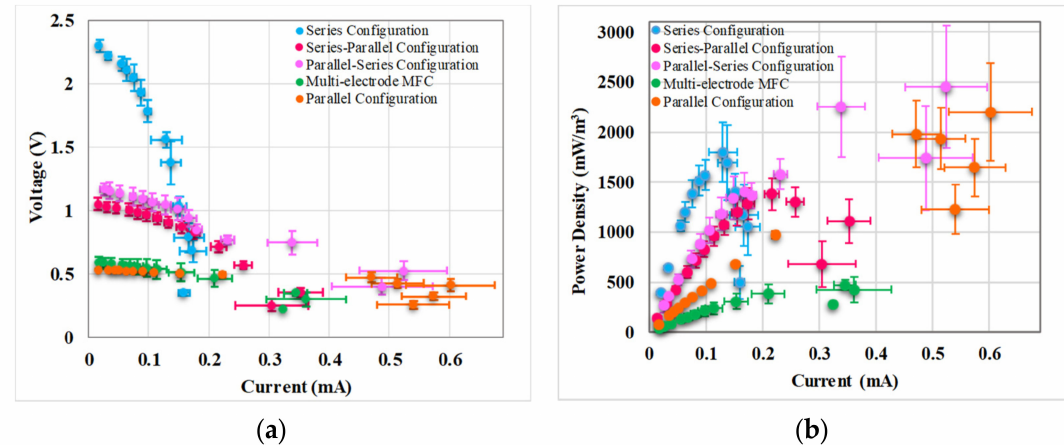
Figure 11. Test 2 results: polarization curves ( a ) and volumetric power density curves ( b ). The calculated standard deviations of the maximum power densities are equal to ± 301.13, ± 490.03, ± 158.24, ± 612.12, and ± 75.34 for the series, parallel, series/parallel, parallel/series, and multi-electrode configurations,